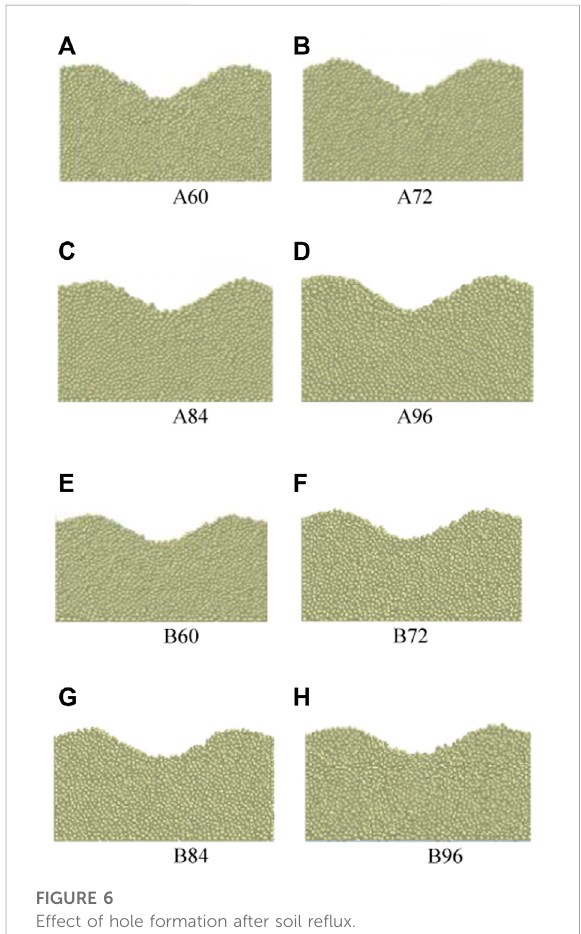
FIGURE 6 Effect of hole formation after soil re fl